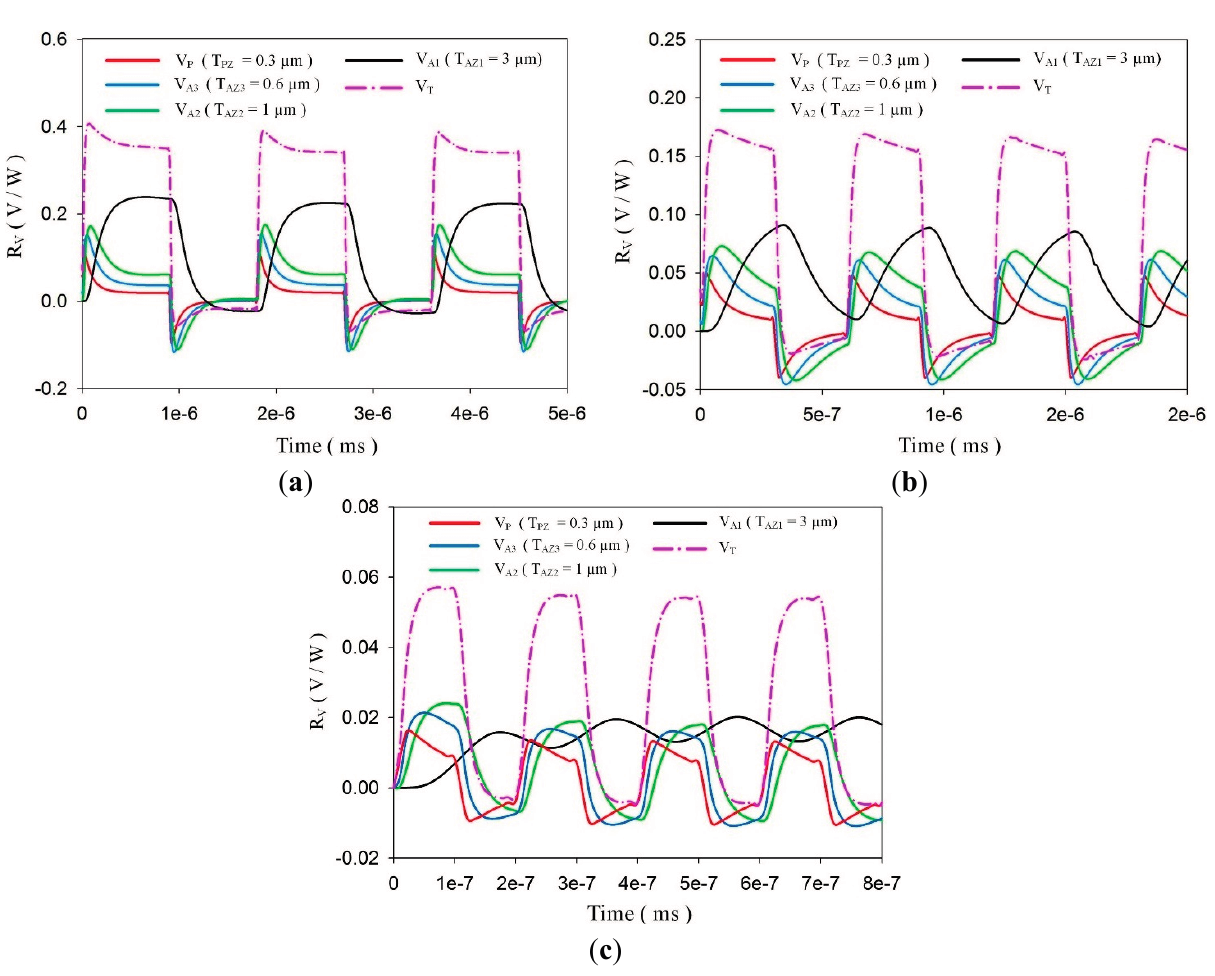
Figure 10. Calculated Voltage responsivities of a meliorated multi-frequency band pyroelectric sensor with T PZ = 0.3 μ m, T AZ1 = 3 μ m, T AZ2 = 1 μ m and T AZ3 = 0.6 μ m under incident irradiation power modulated by various chopping frequencies of about ( a ) 14 KHz, ( b ) 33 KHz and ( c ) 100